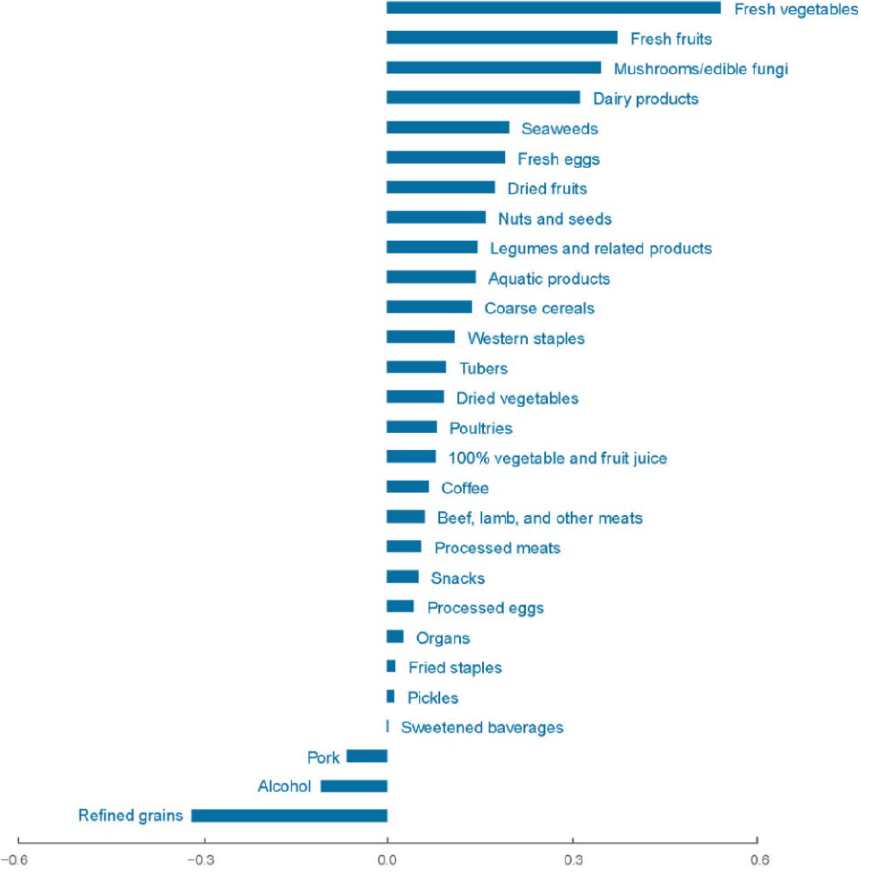
Figure 2. Factor loadings of all food items in BBP-diet.